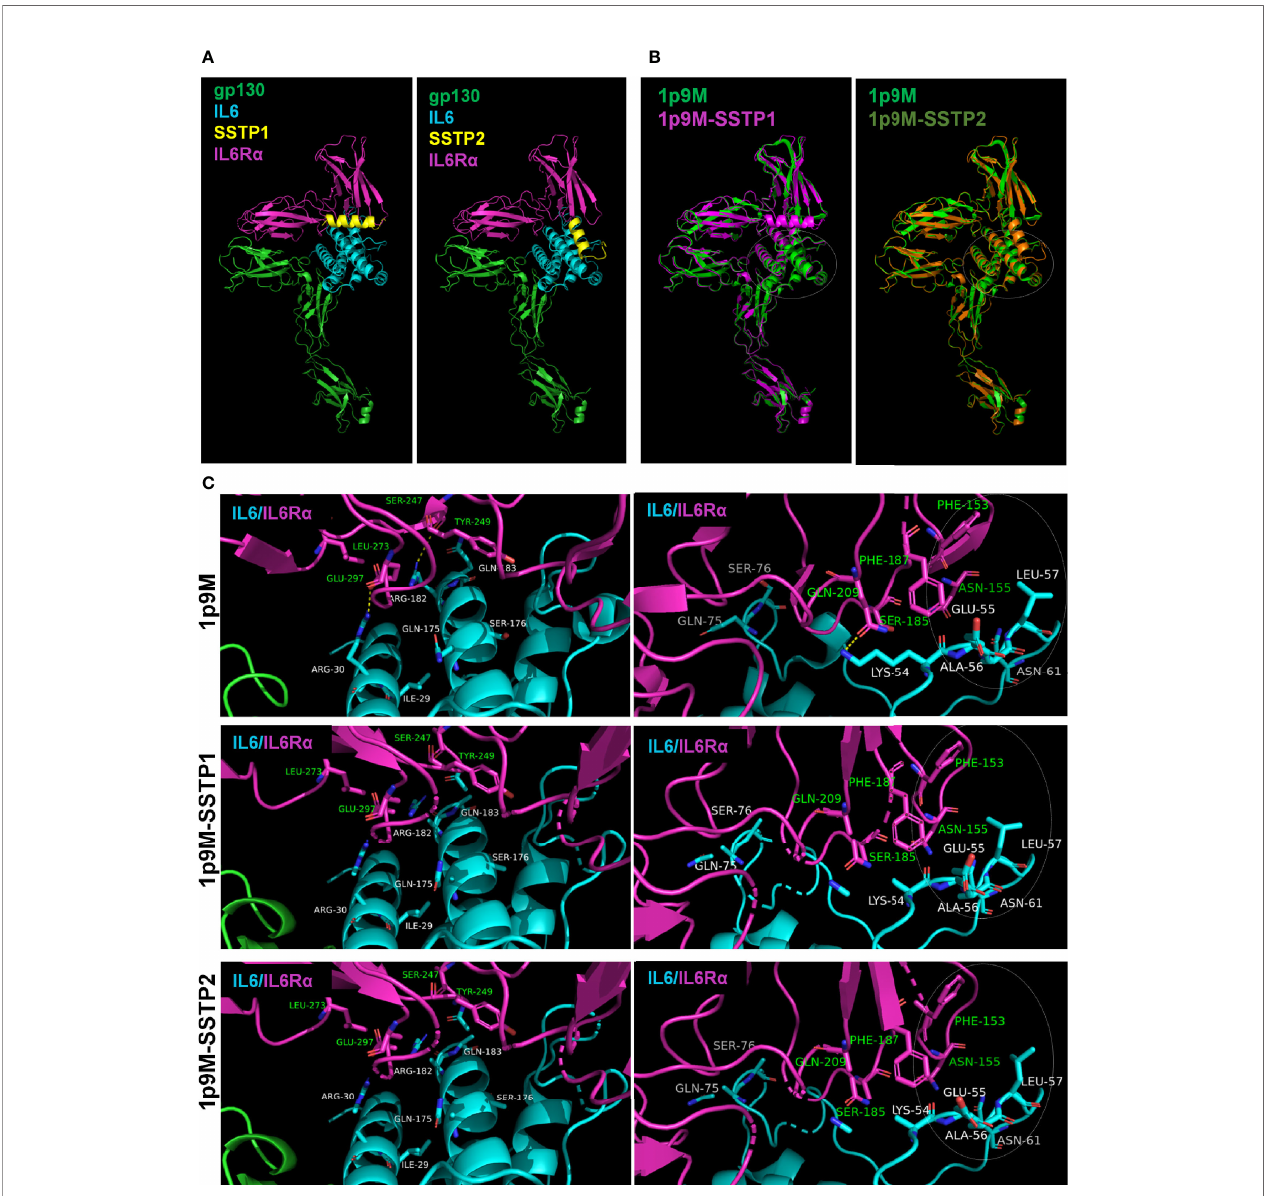
FIGURE 6 | Binding of SSTP1 and SSTP2 to IL6/IL6R a /gp130 complex alters the active site interactions. (A) The predicted structure of SSTP1 and SSTP2 was docked to the crystal structure of trimeric complex 1p9M, and the stable structures identi fi ed were obtained after dynamic simulation. (B) The SSTP1 or SSTP2- bound active trimeric complex was superimposed to 1p9M. The white circle represents the site with unique changes. (C) High resolution images of the interacting residues of IL6 and IL6R a . The residues of IL6 chain is marked using white font color and the green font represents the residues of IL6R a . The circle with dotted line denotes the site with unique